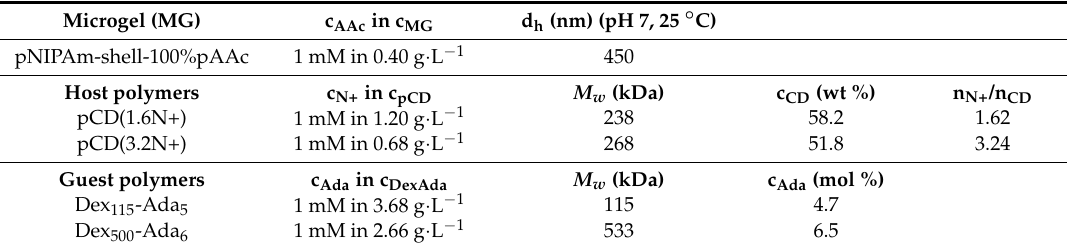
Table 1. Characteristics of the synthetized polymers and